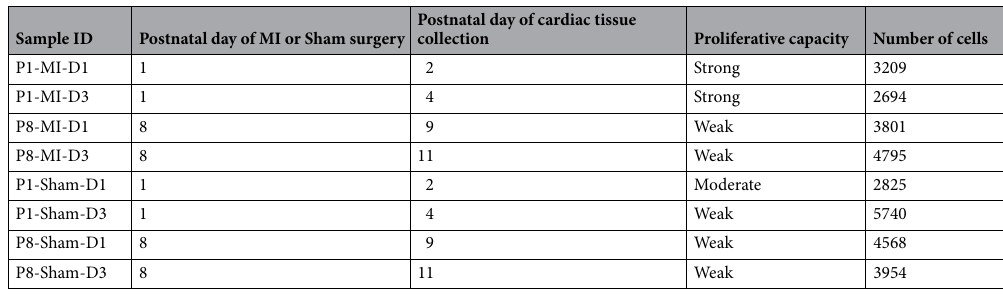
Table 1. Mouse scRNA dataset (GSE130699) 14